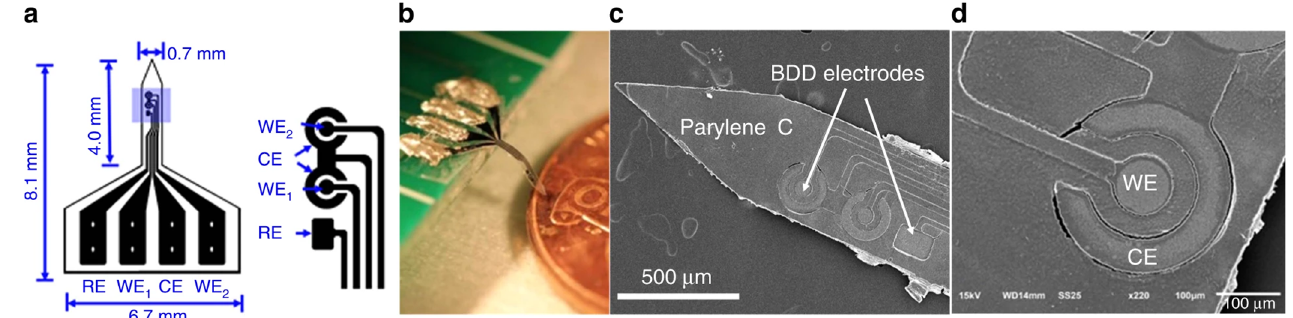
Figure 6. ( a ) Diagram of the BDD microelectrode probe. ( b , c ) Picture and SEM images of the manu- factured neural probe. ( d ) A close-up view of the BDD WE and CE have been provided by the SEM